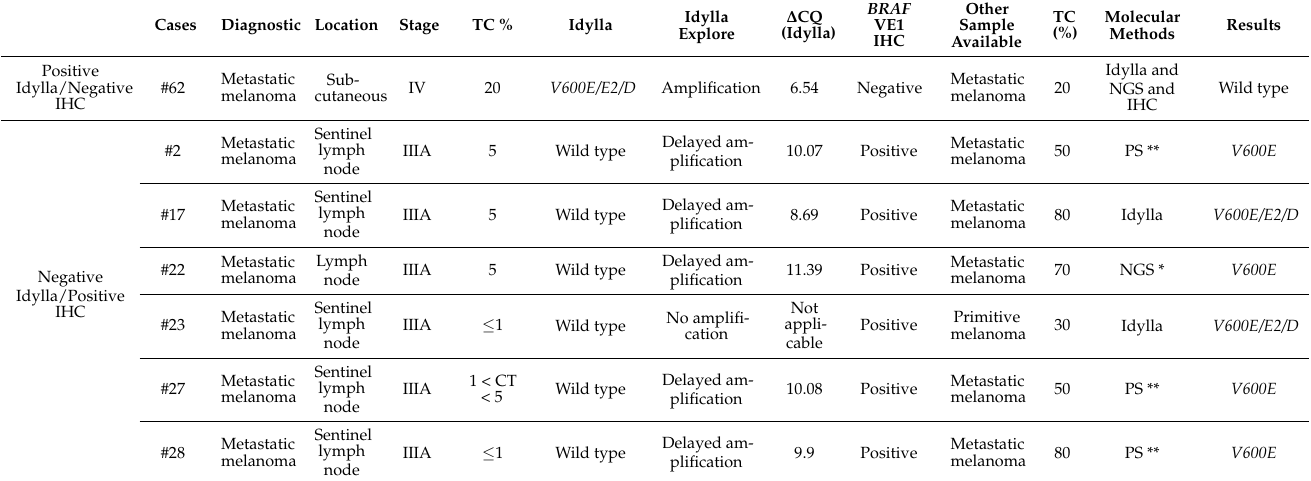
Table 3. Analysis of discordant results.